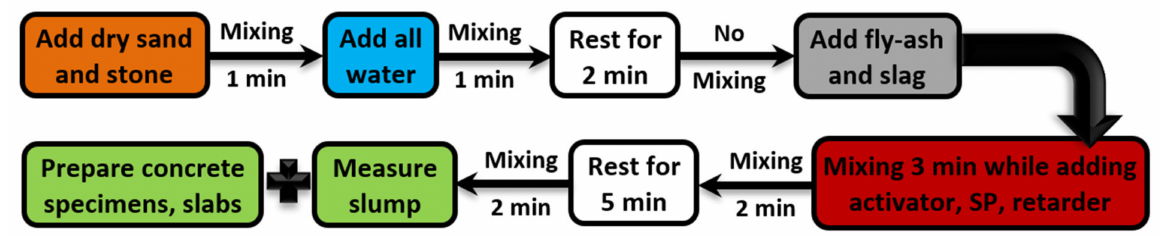
Figure 2. Geopolymer concrete mixing procedure.